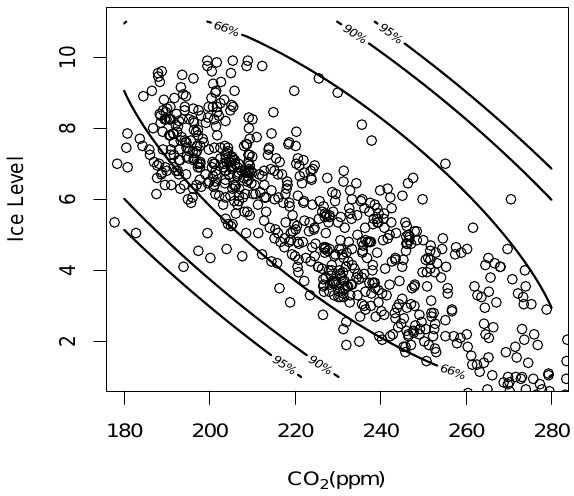
Figure 3. Lines: 66, 90 and 95% percentiles of the empirical dis- tribution used to describe the probability distribution in the CO 2 – ice space (Eq. 8). Dots: observations of CO 2 (Luethi et al., 2008; Siegenthaler et al., 2005; Petit et al., 1999) and estimates of ice level assuming a linear relationship with the LR04 stack of ben- thic foraminifera δ 18 O (Lisiecki and Raymo, 2005) over the last 800000 years. Based on these observations, the empirical distribu- tion appears to be slightly biased towards high ice level at low CO 2